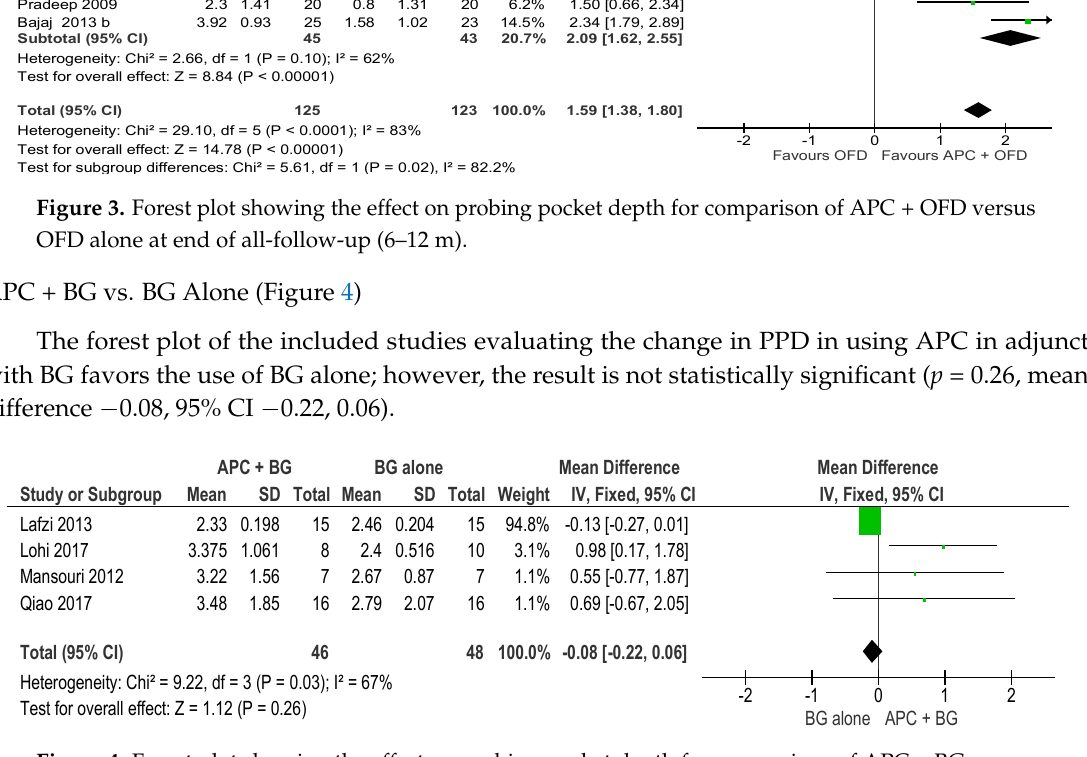
Figure 4. Forest plot showing the effect on probing pocket depth for comparison of APC + BG versus BG alone at end of all-follow-up (6–12 m) .